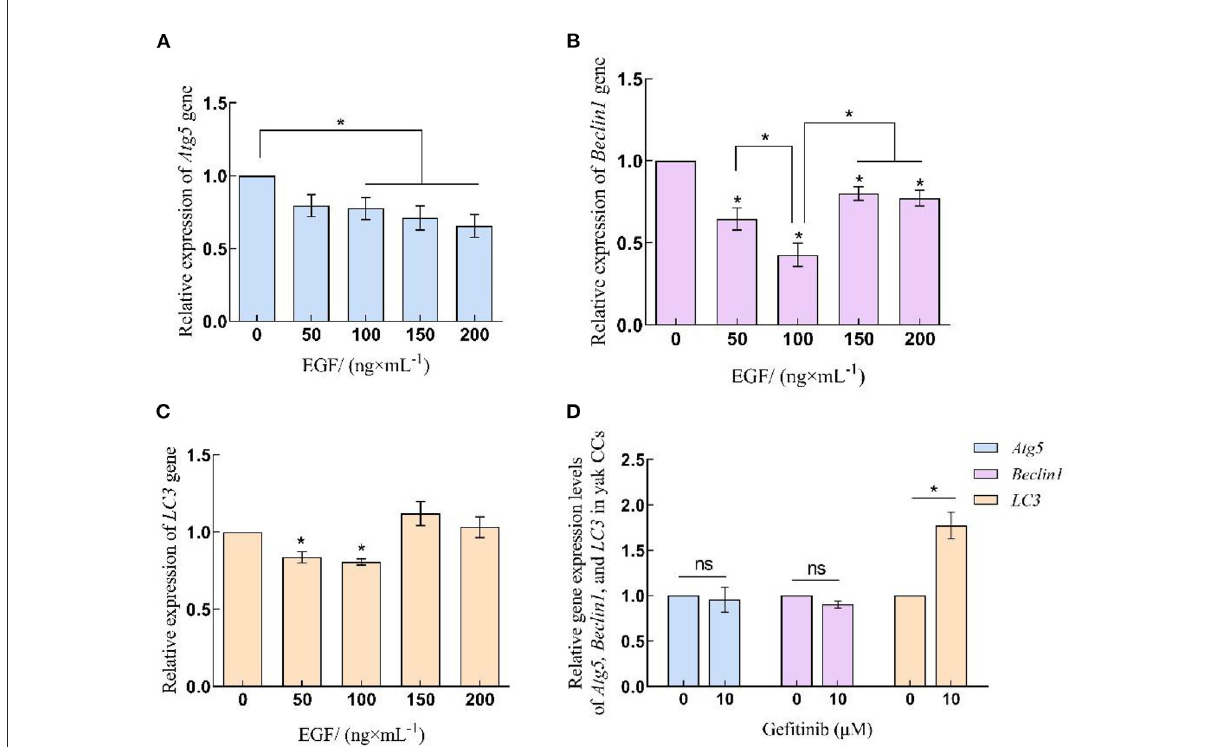
FIGURE2 Relative expression levels of Atg5, Beclin1 and LC3 gene in yak CCs treated with different concentrations of EGF and the optimal concentration of gefitinib (EGFR inhibitor). (A–C) Relative mRNA expression levels of Atg5, Beclin1, and LC3 in yak CCs (EGF group). (D) Relative mRNA expression levels of Atg5, Beclin1, and LC3 in yak CCs (Gefitinib group). *on the bars indicates values that differ significantly (* P < 0.05).